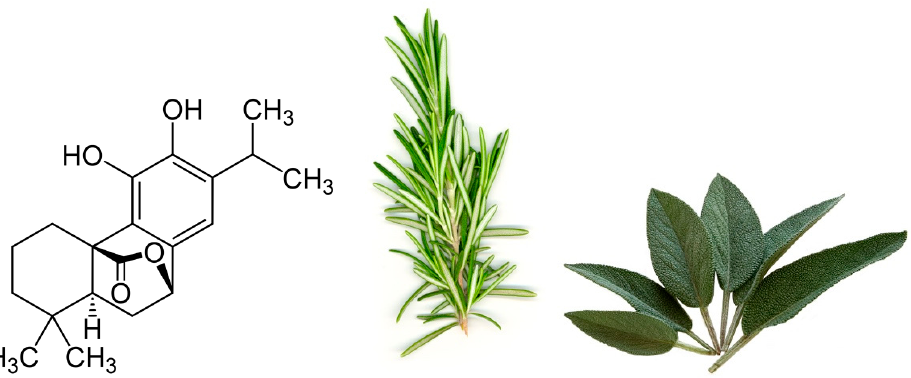
Figure 1. Chemical structure of carnosol found in rosemary and sage.